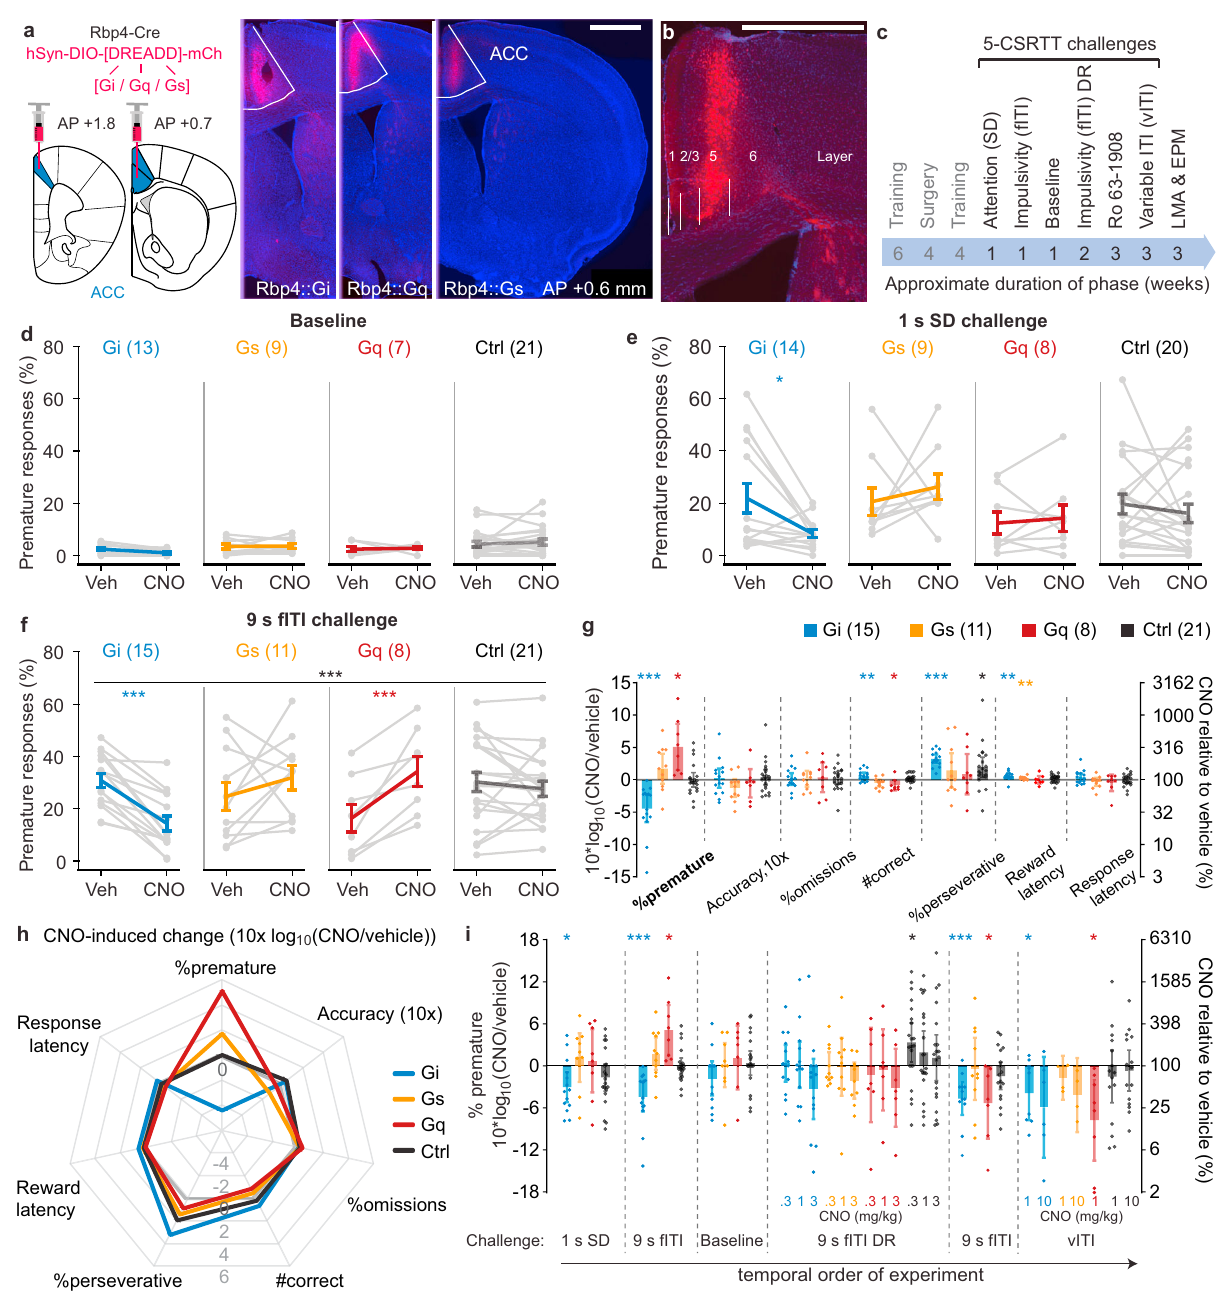
Fig. 2 Activation of the G i -cascade in ACC L5-PCs reduces premature responding in parametric challenges of impulsivity. a Transfection (left) and Cre- dependent expression (right) of hM4Di-mCherry (G i ), hM3Dq (G q ) and rM3Ds (G s ) in ACC L5-PCs in coronal slices collected at ~0.6mm anterior of bregma; scale bar, 1mm. b Laminar expression of hM4Di-mCherry (red); scale bar, 1mm. c Temporal order of surgery and chemogenetic/behavioural testing, including the duration for each test phase; all tests except for the EPM were conducted within-subject with vehicle and CNO applications separated by 3-7 d. d – f Premature responses after injection of vehicle (Veh) or CNO for the four subgroups of the cohort [G i (blue), G s (orange), G q (red), mCherry-controls (Ctrl; black), N